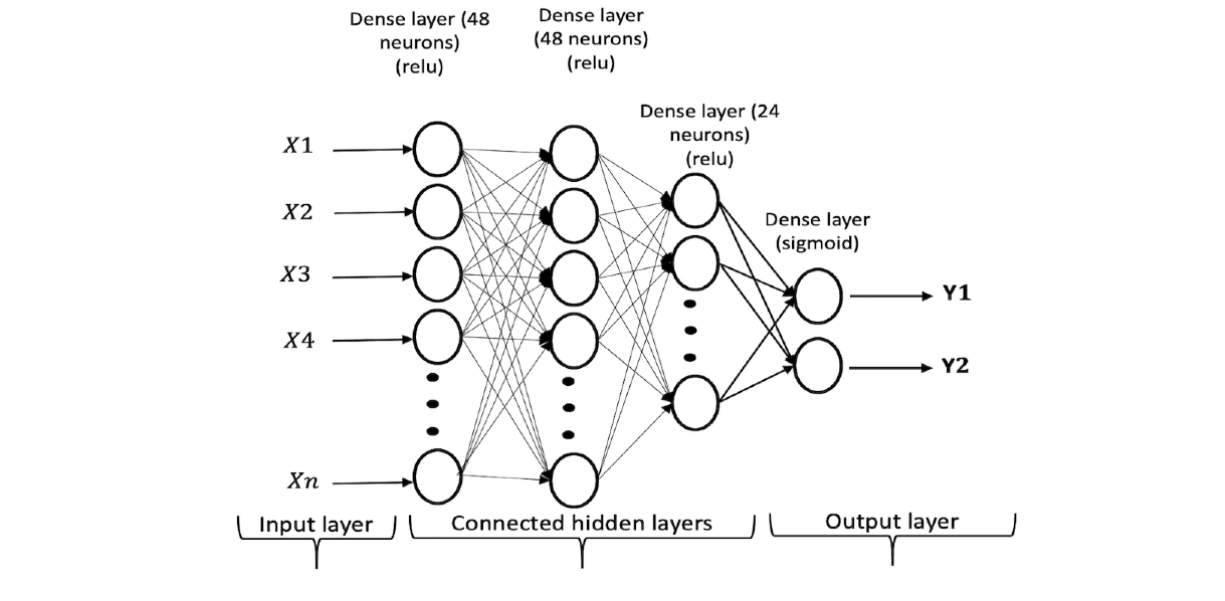
Figure 3. The structure used for multilayer perceptron trained with the longitudinal data. relu: rectified linear